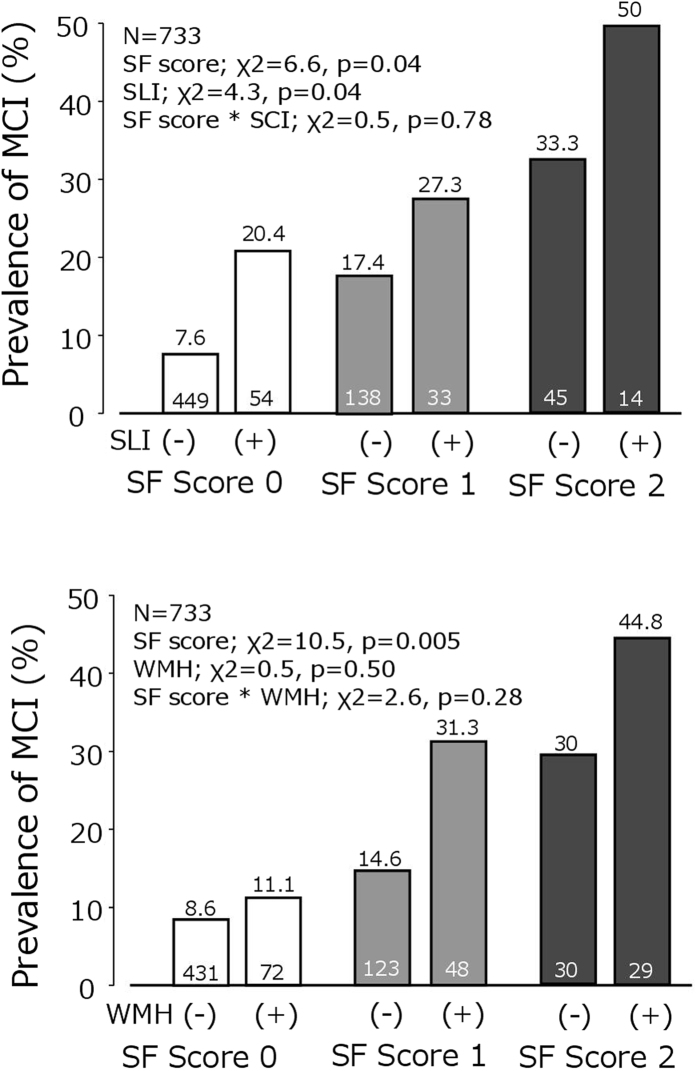
Relationship between simple frailty (SF) score, presence of silent lacunar infarction (SLI), white matter hyperintensity (WMH) and mild cognitive impairment (MCI).The number in the column represents the number of participants. The number above the column indicates the prevalence (%) of MCI. Adjustment for age and sex was performed with logistic regression analyses with interactions between SF score and the presence of SLI or WMH.